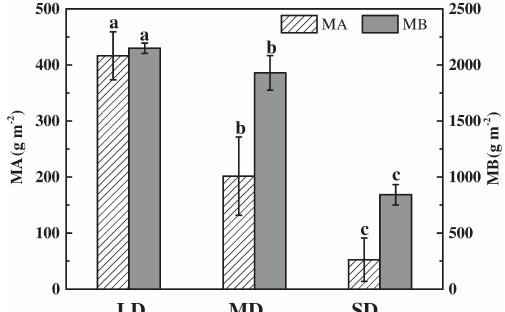
Figure 2. MA and MB of different degradation degrees. The er- ror bars denote the standard deviation of the 3 sites of the same degradation degree. Different letters above the bars denote signifi- cant differences ( p < 0.05) between different degradation